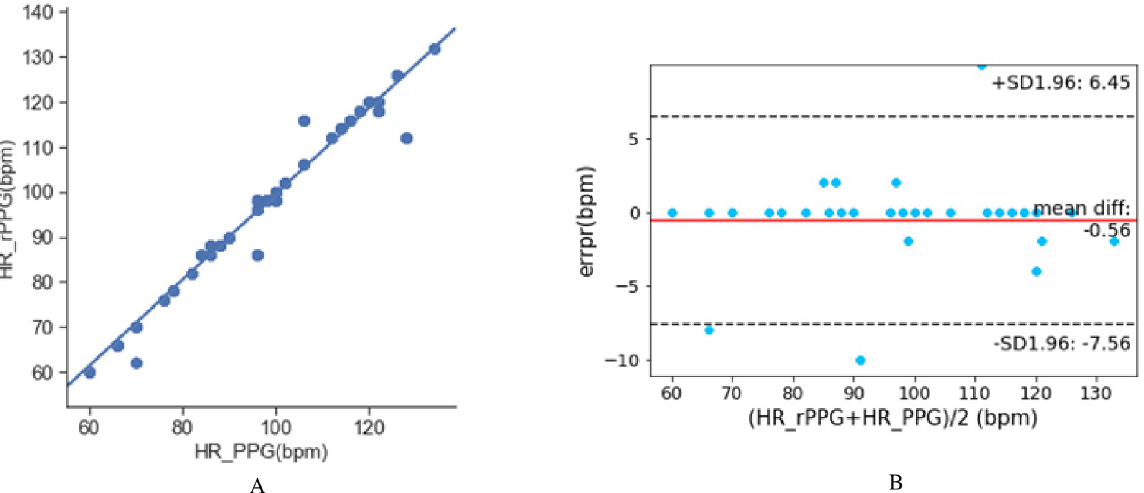
Fig 13. The comparison of HR values obtained by the proposed method and the contact measurement method. A: Linear regression diagram. B: Bland-Altman diagram.